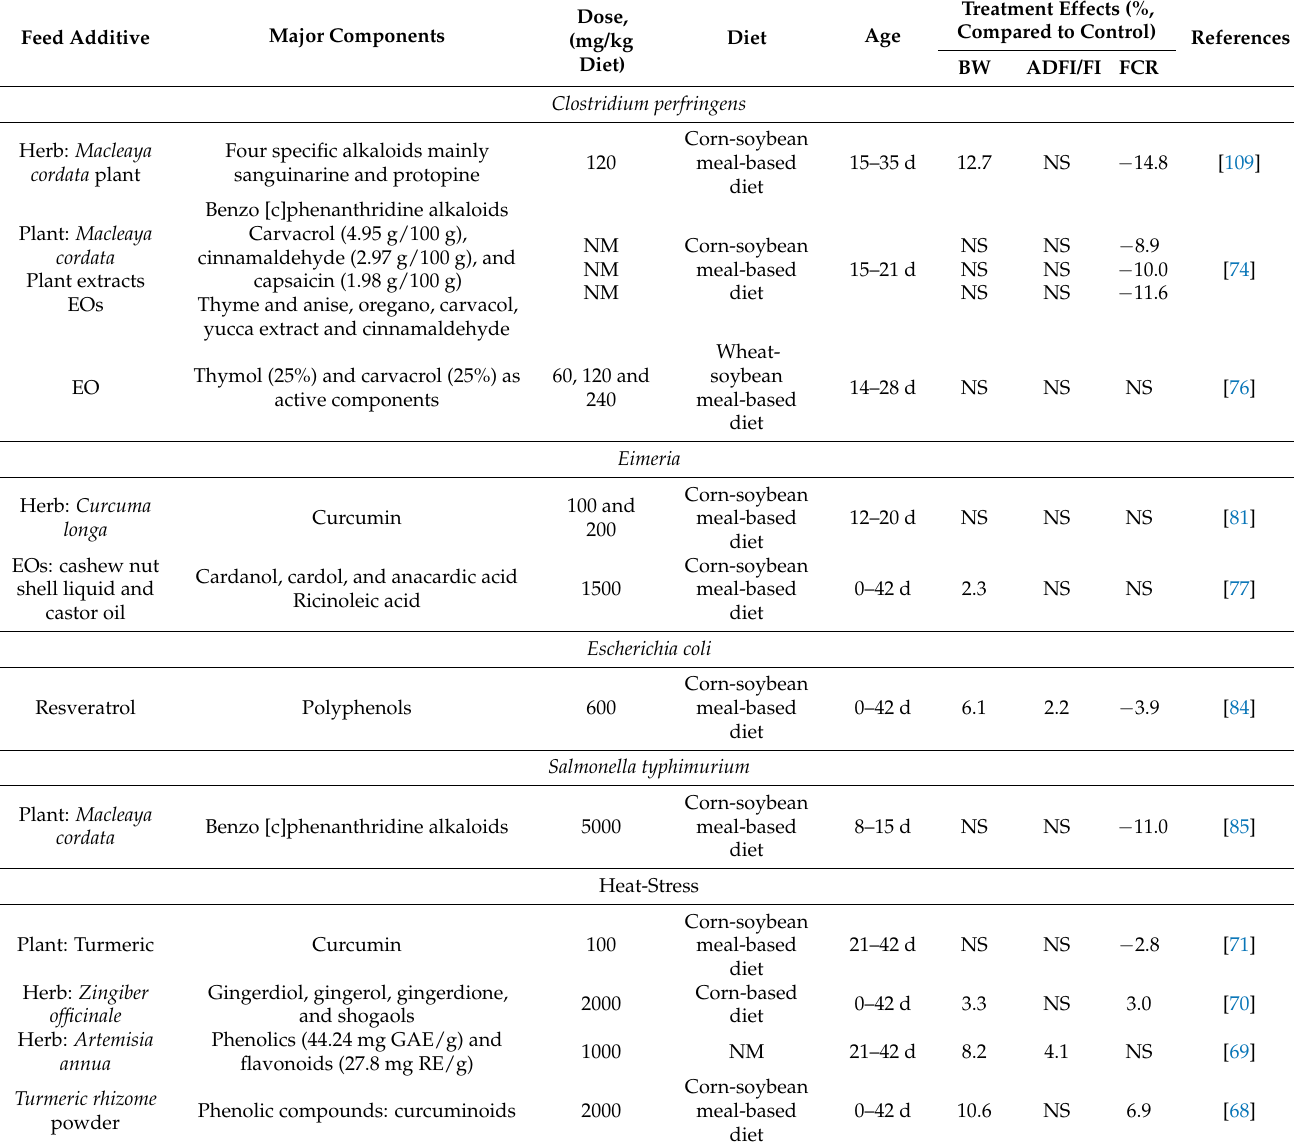
Table 4. Effects of dietary supplementation of PFAs on growth performance of broilers under challenging conditions.